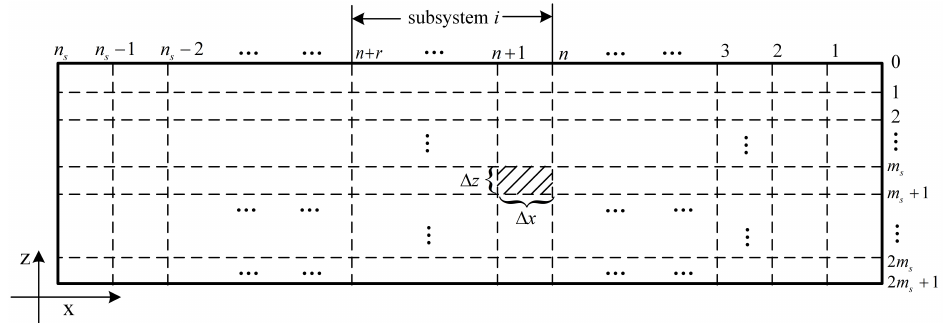
Figure 3. Illustration of the mesh